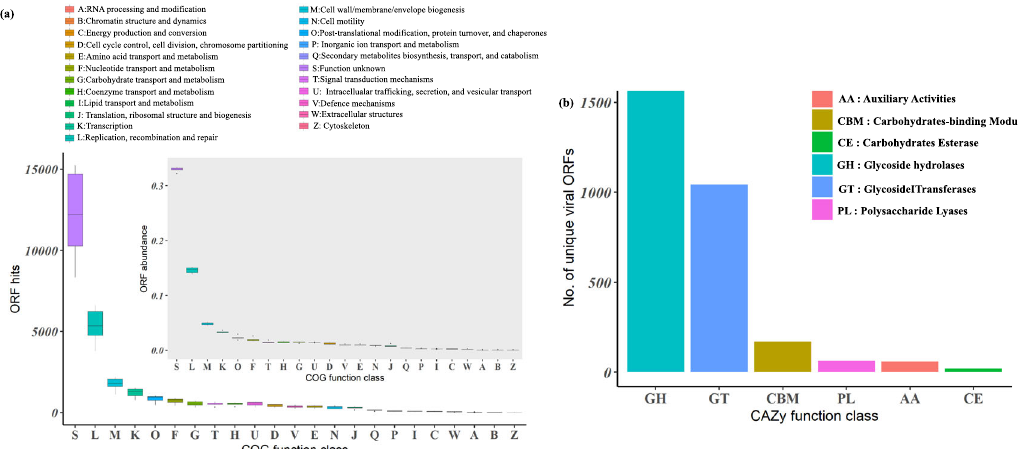
Fig. 5 Distribution of auxiliary metabolic genes (AMGs) relevant to the carbon cycle and nutrient removal. a Boxplot of the overall gene pro fi le for six WWTPs was summarized both as viral ORF hits and viral ORF relative abundance (ORF hits to each COG function class/total ORFs that have hits to eggNOG database). Data in a are presented as mean values (center) and 25%, 75% percentiles (bounds of box). The minima and maxima represent the range of the data. b Number of unique viral ORFs related to each CAZy function class was shown in a descendant order. Source data are provided as a Source Data fi